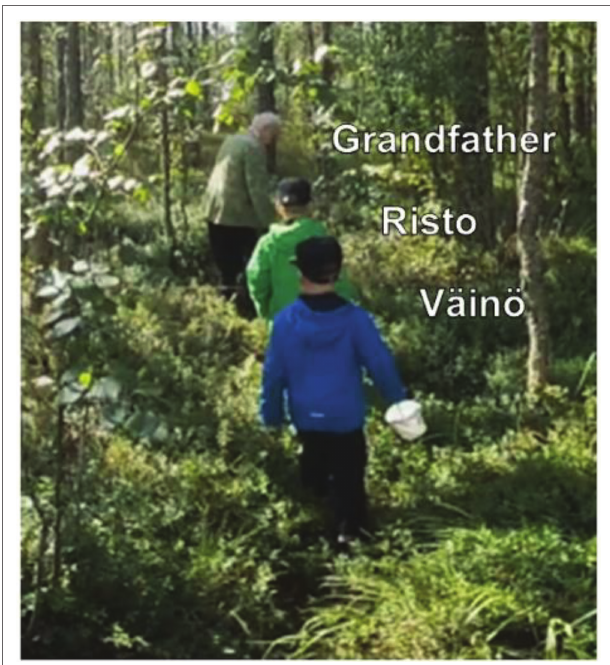
FIGURE 1 | Grandfather, Risto and Väinö are walking into the woods to pick